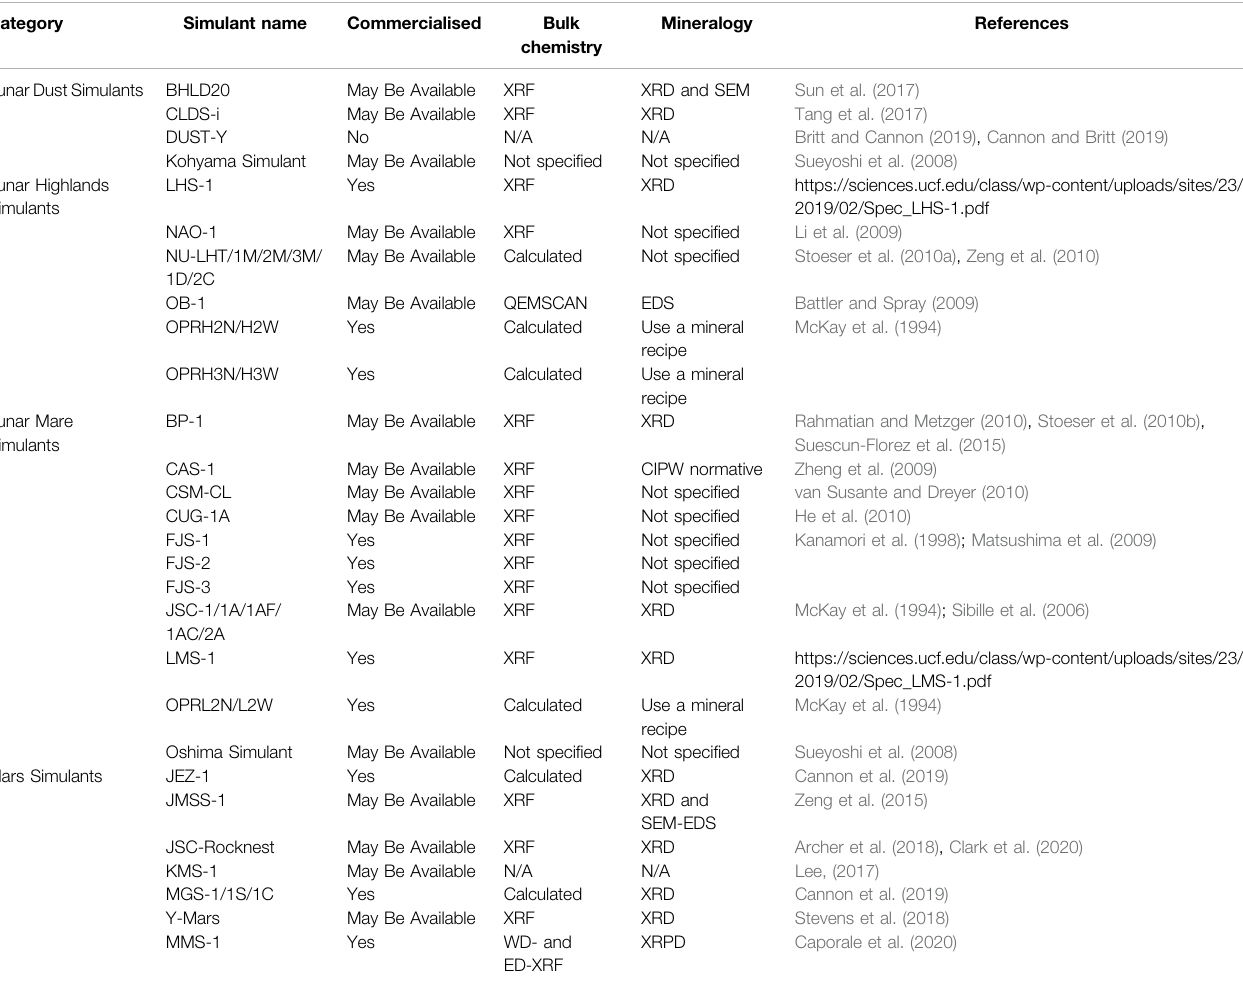
TABLE 1 | List of the simulants considered in the present work, divided by reference category. In detail the availability on the market and the reference analysis for chemical and mineralogical characteristics.